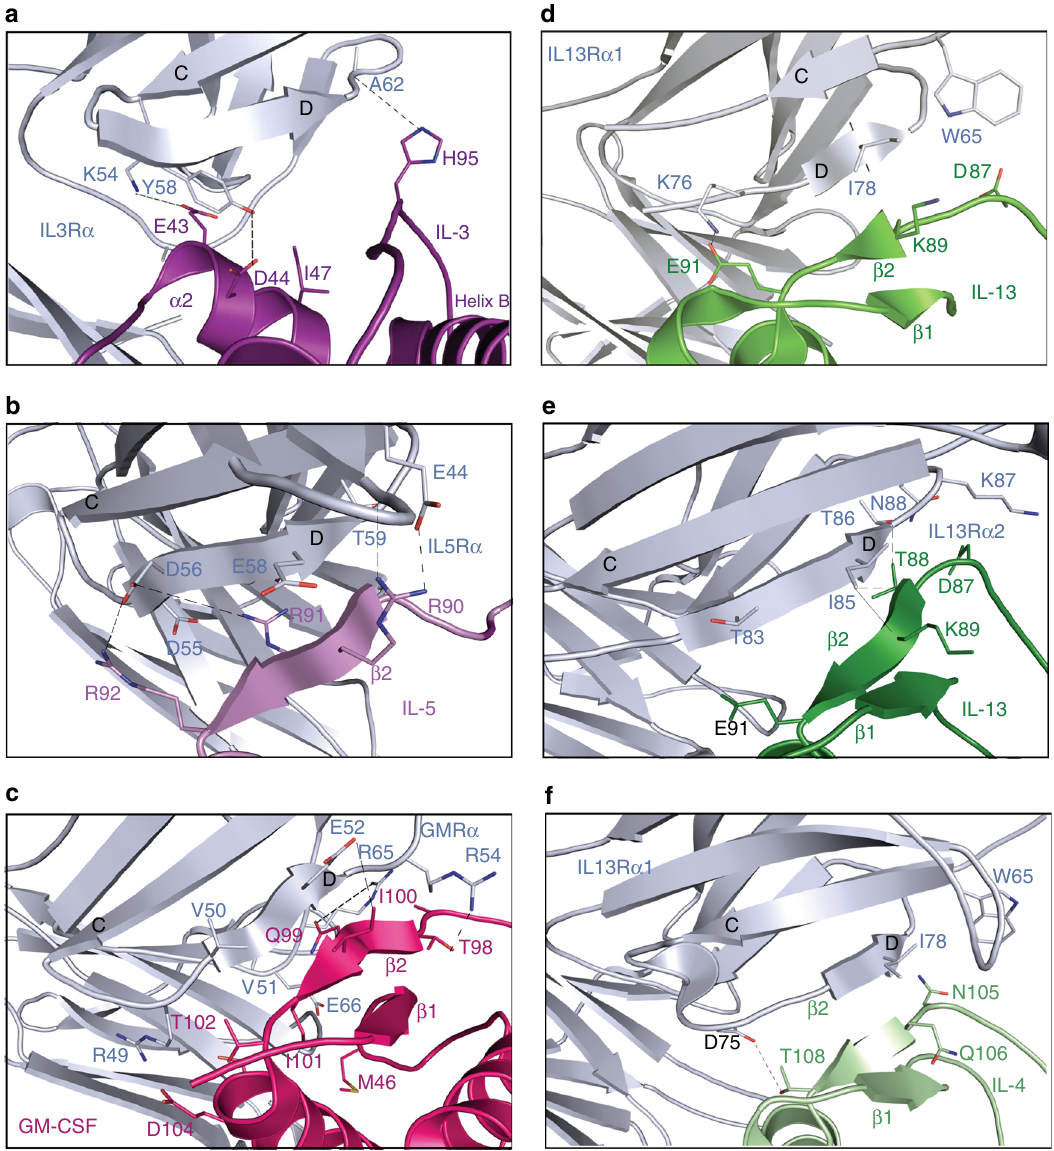
Fig. 2 Comparison of IL3R α site 1b interactions to related cytokine receptor complexes. a Wild-type IL-3:IL3R α binary complex. b IL-5:IL5R α binary complex (PDB ID: 3VA2, 3QT2 20,21 ). c GM-CSF:GMR α binary complex (PDB ID: 4RS1 19 ). d IL-13:IL13R α 1 component of the ternary complex (PDB ID: 3BPO 22 ). e IL- 13:IL13R α 2 binary complex (PDB ID: 3LB6 23 ). f IL-4:IL13R α 1 component of the ternary complex (PDB ID: 3BPN 22